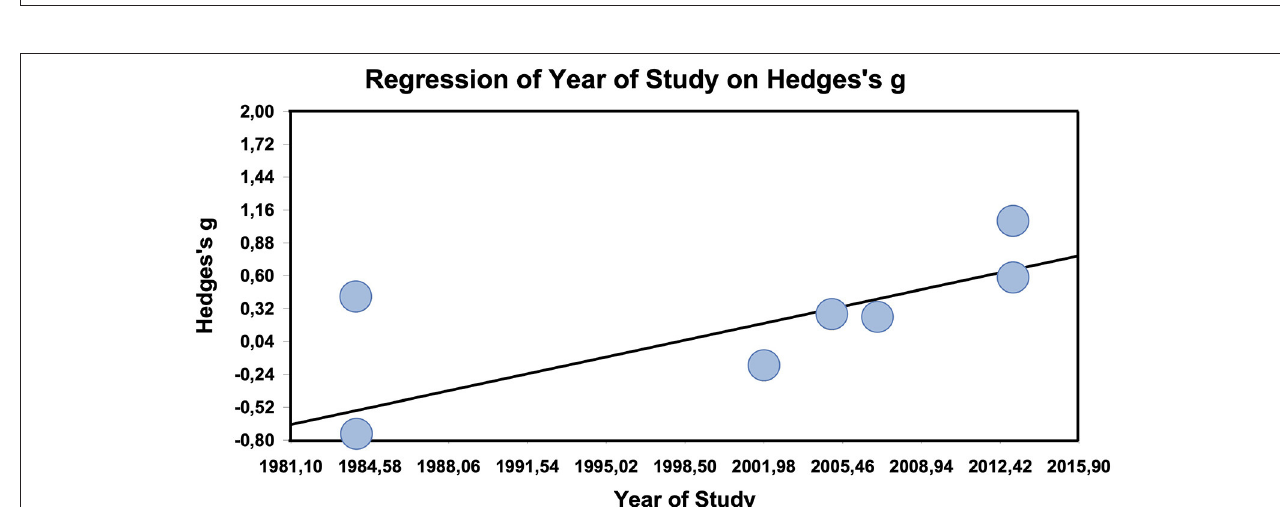
FIGURE 4 | Meta-regression of year of study on effect size in other-than-placebo-controlled trials ( n =